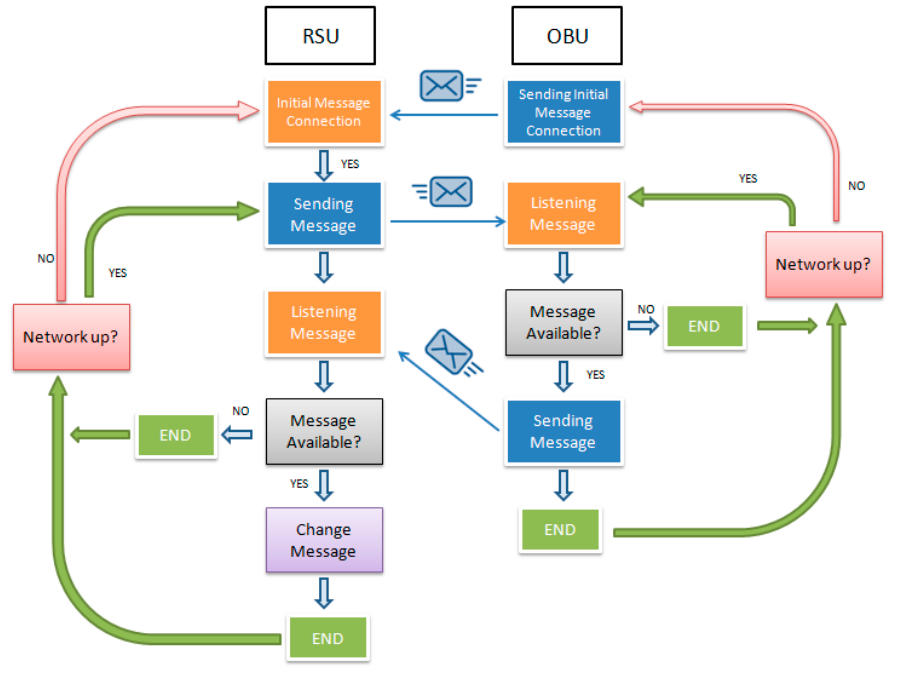
Figure 5. Flow diagram for the algorithm implemented for Wi-Fi .